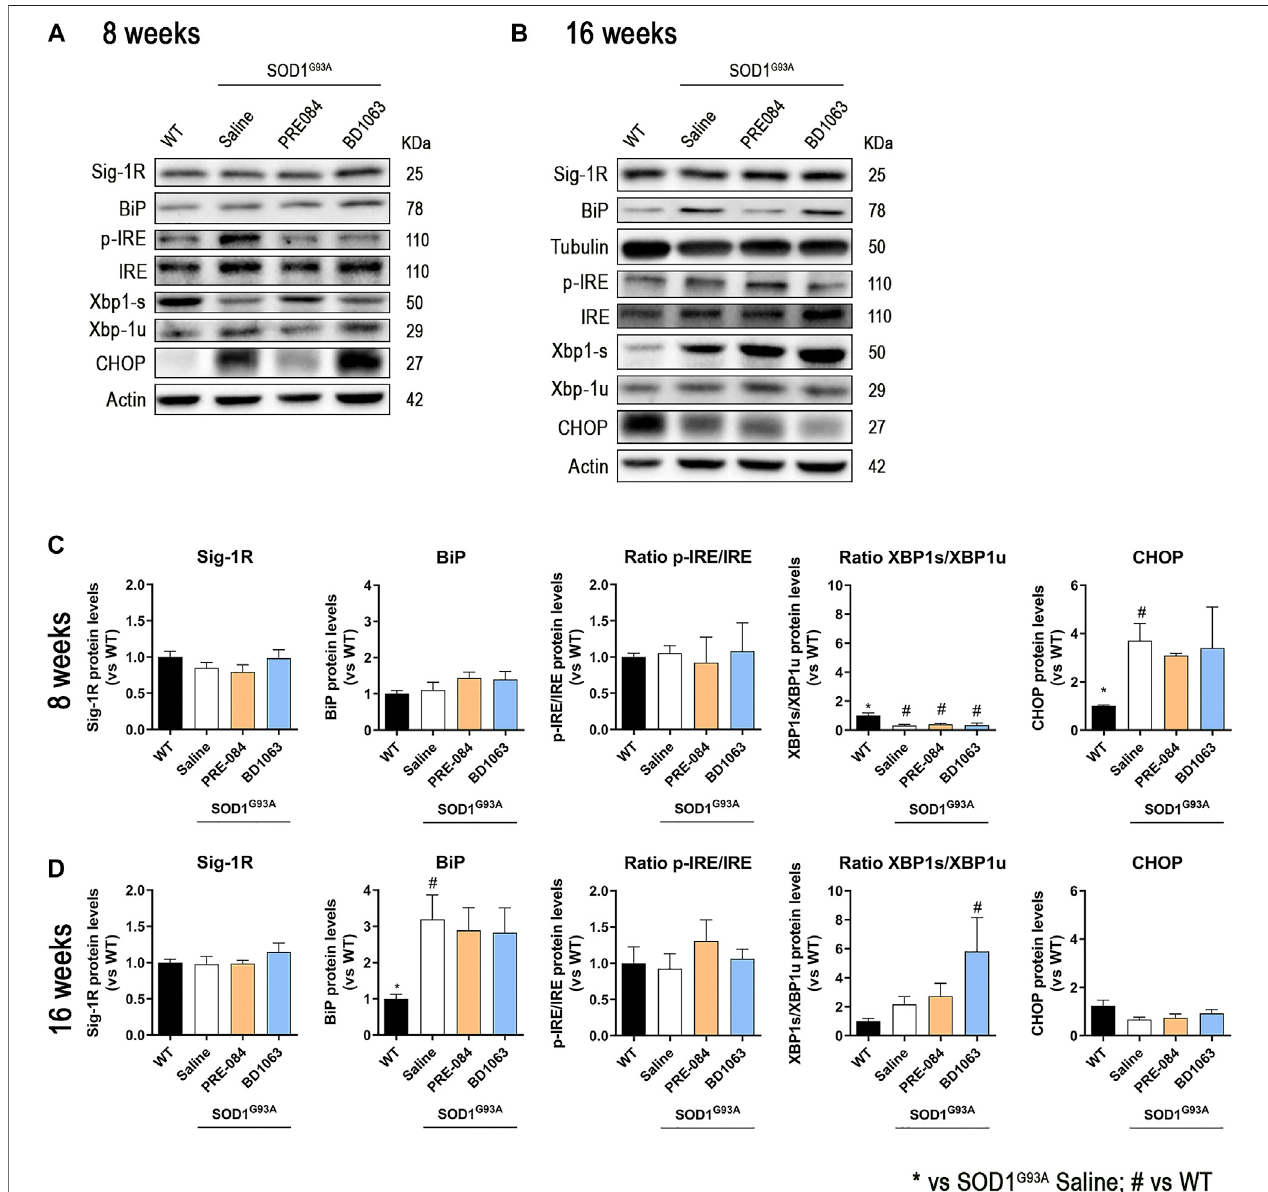
FIGURE 5 | Protein levels of ER stress markers in SOD1 G93A female mice. Representative blots of ER stress markers at 8 (A) and 16 (B) weeks of age. Quanti fi cationofproteinlevelsofSig-1R,BiP,ratiop-IRE1/IRE1,ratioXBP1s/XBP1unsplicedandCHOPat8 (C) and16 (D) weeksofage.Dataismean ± SEM;n (cid:1) three to fi ve mice per group. One-way ANOVA followed with Bonferroni ’ s post hoc test for multiple comparison. * p < 0.05 vs SOD1 G93A saline, # p < 0.05 vs WT.